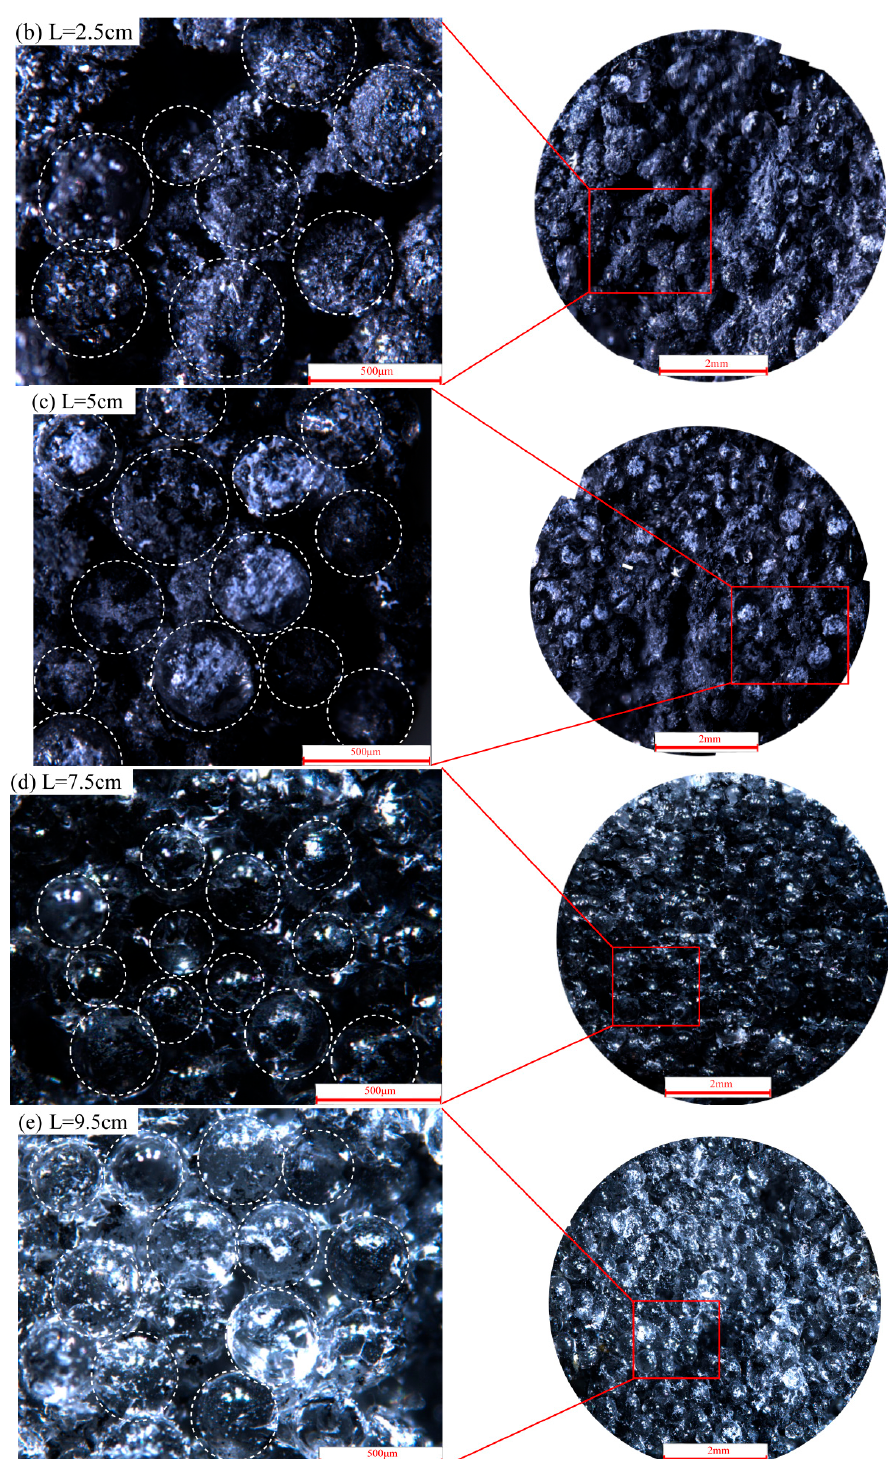
Figure 4. Iron distribution in porous media cross-sections at different column distances (L). The white dashed circles indicate porous glass beads: ( a ) L = 0.5 cm; ( b ) L = 2.5 cm; ( c ) L = 5 cm; ( d ) L = 7.5 cm; ( e ) L = 9.5 cm.